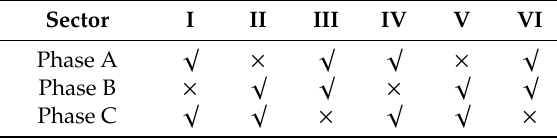
Table 2. The influence of fault in phase A, B, and C.